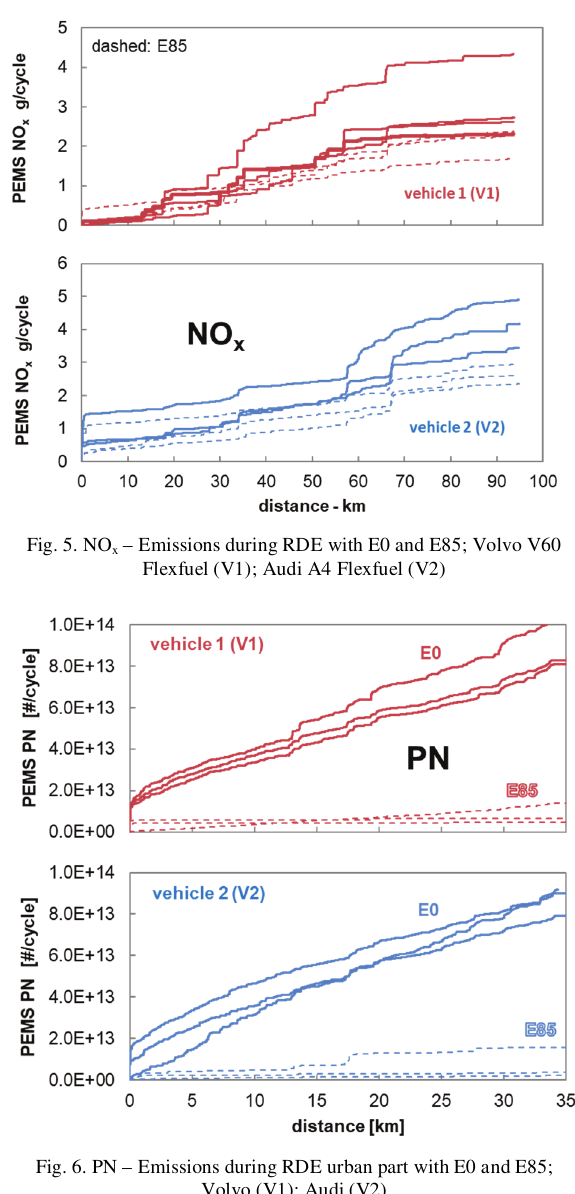
Fig. 8. CO – Emissions during RDE with E0 and E85; Volvo (V1); Audi